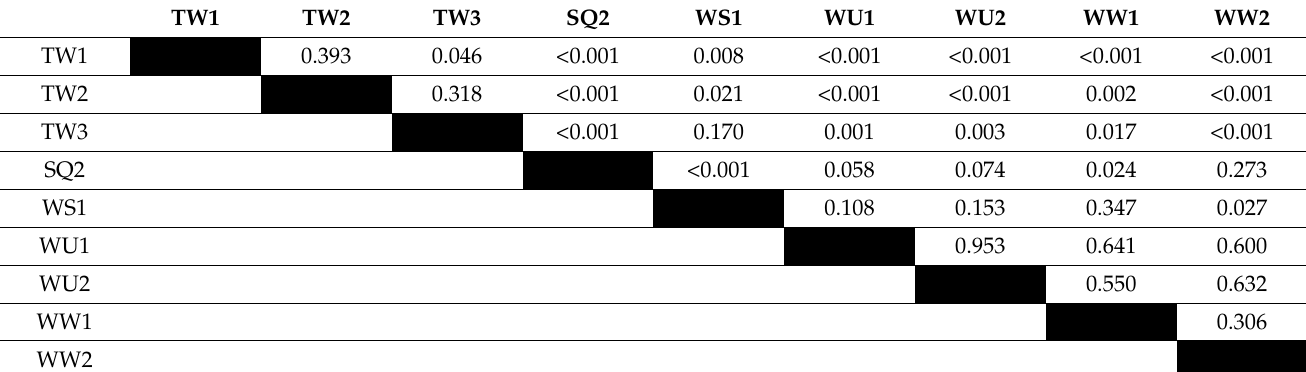
Table A4. Wilcoxon sum test p -values, Enterococci